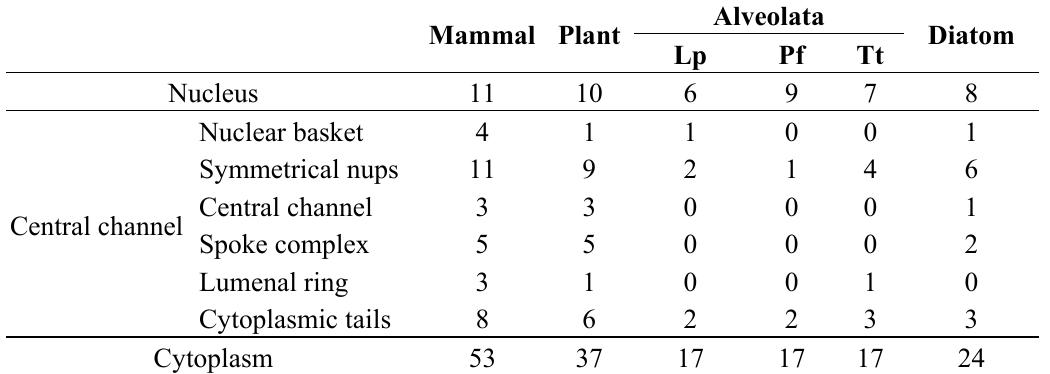
Table 1. Number of components involved in nuclear transport found in the L. polyedrum transcriptome. Gene sequences for various Kyoto Encyclopedia of Genes and Genomes (KEGG) pathways were tabulated. The alveolates are represented by L. polyedrum (Lp), Plasmodium falciparum (Pf) and Tetrahymena thermophila (Tt). A cutoff value of e − 25 was used to assess the presence of